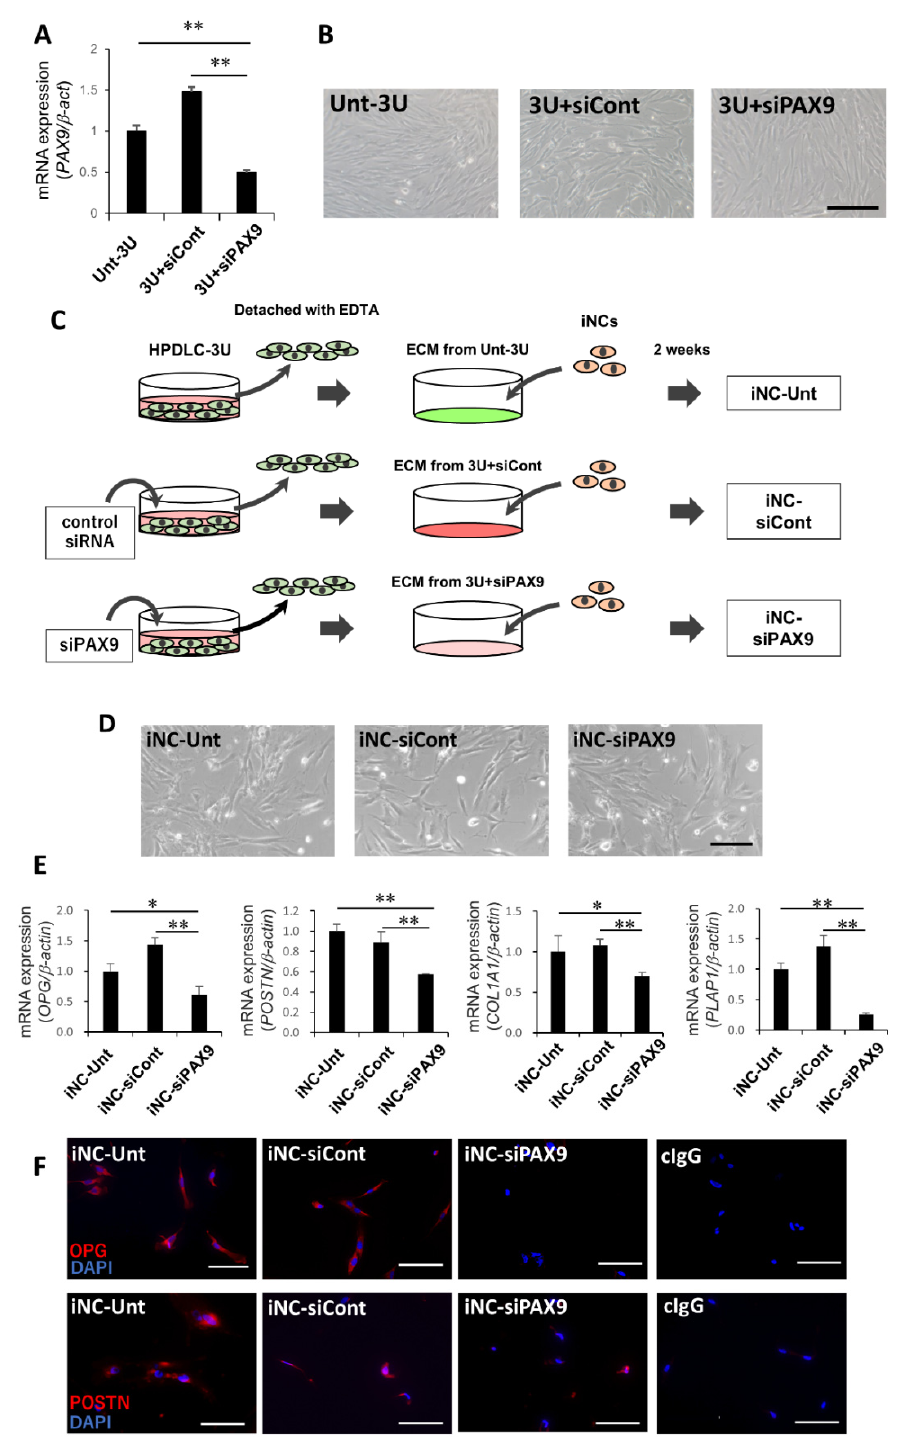
Figure 3. The downregulation of gene and protein expression of iPDLSC-associated markers in iNC-siPAX9. ( A ) Quantitative real-time RT-PCR analysis of PAX9 in Unt-3U, 3U + siCont, and 3U + siPAX9. β -act was used as an internal standard. Data are portrayed as the mean ± standard deviation ( n = 4). ** p < 0.01. ( B ) Representative phase-contrast microscopic images of Unt-3U, 3U + siCont, and 3U + siPAX9. Bar = 200 µ m. Unt-3U, untransfected HPDLC-3U; 3U + siCont, control siRNA-transfected HPDLC-3U; 3U + siPAX9, siPAX9-transfected HPDLC-3U. ( C )